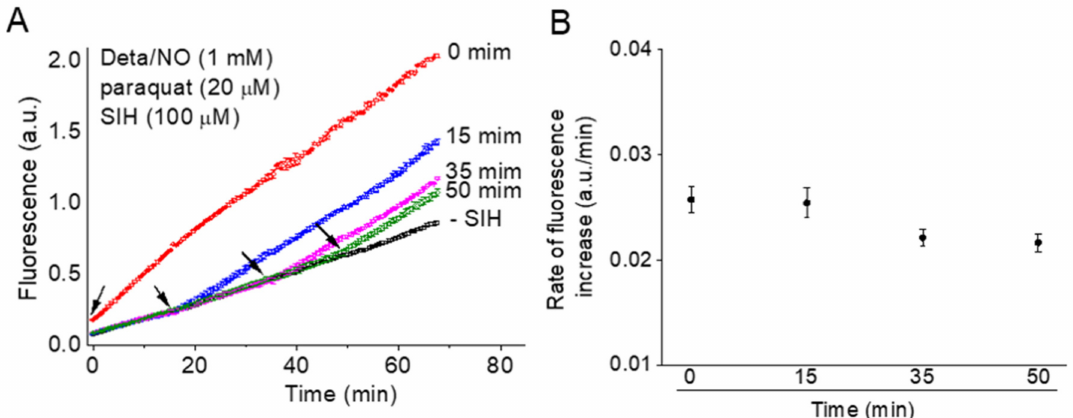
Figure 5. The rate of intracellular oxidation of H 2 DCF as a function of the time when SIH was added. ( A ). Fluorescence traces due to the formation of DCF. The experiments were performed as described in Figure 4; 2,2 (cid:48) -(hydroxy-nitroso- hydrazono)bis-ethanimine (Deta/NO) was used as NO • donor in the presence of paraquat. SIH was added before or at selected time points during the run, as designated in the figure. Deta/NO has a long half-life under the experimental conditions, producing a constant flux of NO • in the time scale of the experiments. The data represent the mean ± S.D. of four experiments; ( B ). The rate at which the fluorescence increased after SIH was introduced. The rate was determined by linear regression of the fluorescence traces in the final 5 min of the collected data. The data represent the mean of four independent experiments ± S.D. The conditions and fluorescence acquisition and parameter settings were the same as those described in Figure